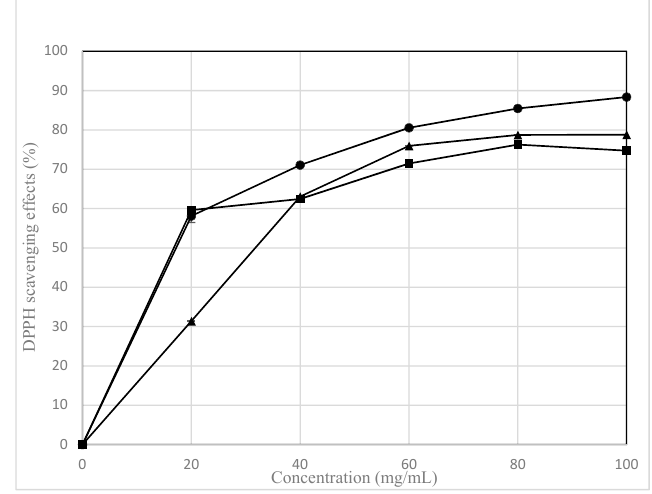
Figure 1. Scavenging activity on DPPH radicals of the methanol, ethanol, and water extracts in LGK (six months fermented Godulbaegi kimchi). The symbols express the following samples: closed circle, methanol extract; closed triangle, ethanol extract; closed square, water extract.